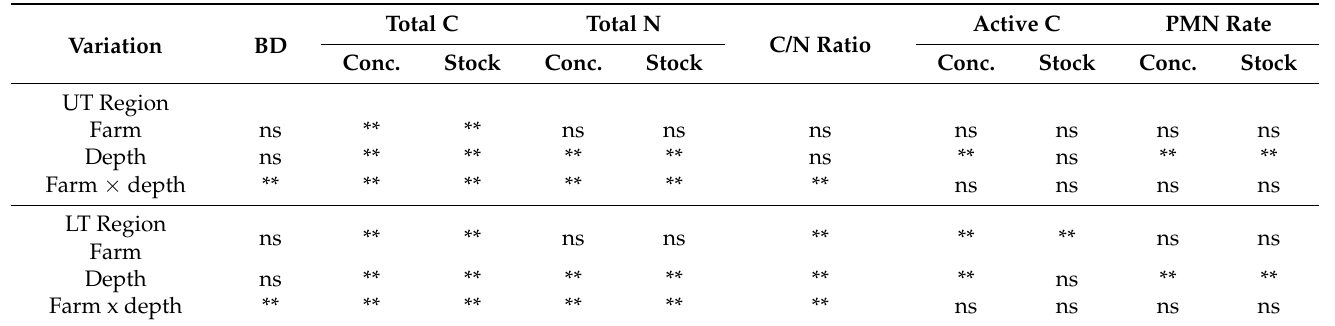
Table 4. Summary of the REML analyses on selected soil quality indicators under mixed pastures in the Upper (UT) and Lower (LT) Tsitsikamma dairy farms.